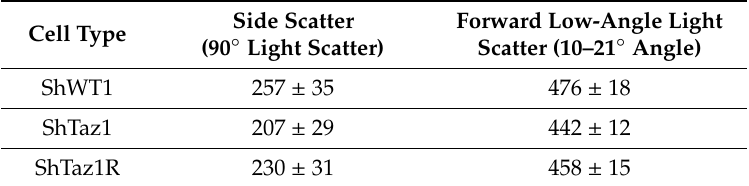
Table 1. Flow cytometry measurements of the cell light scatter. Side Scatter Cell Type (90 ◦ Light Scatter)